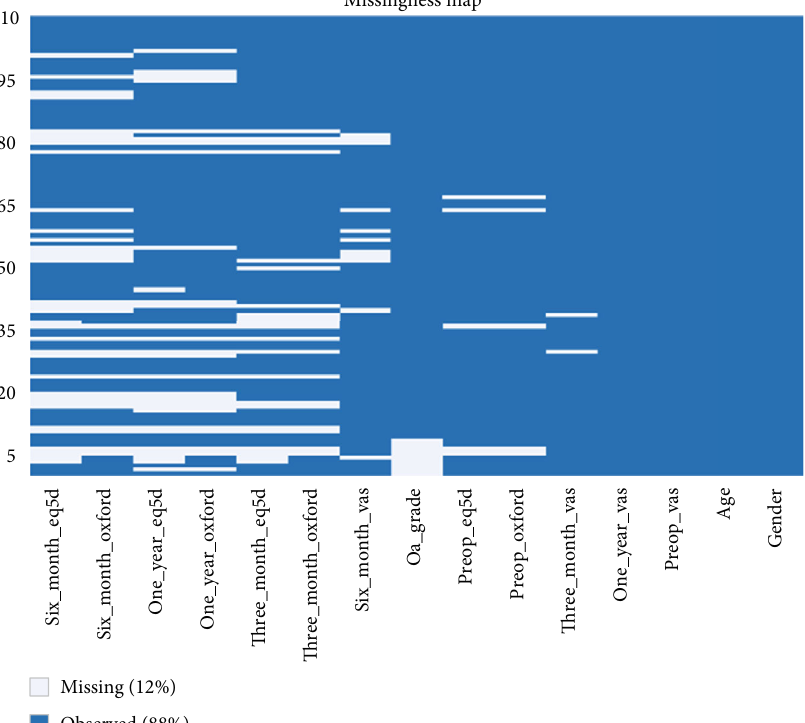
Figure 4: Missingness map. x -axis: outcome variables: gender, age, Visual Analogue Scale (VAS) for pain, Oxford Knee Score (OKS) for function, and EQ5D for quality of life at preoperative baseline and three, six, and twelve months follow-up. y -axis: data points missing at random (12%) due to patients lost-to-follow-up: missing data have been estimated probabilistically with uncertainty using the statistical software package Amelia v1.7.6 or higher. The estimation procedure is replicable and reproducible with Open Access statistical software R (4.0.0 or higher). The missingness map shows the missing data fi elds in our dataset. All patients have a preprocedure and 1 year VAS for pain as seen on the right-hand column of the plot. The left-hand column then the missing OKS and